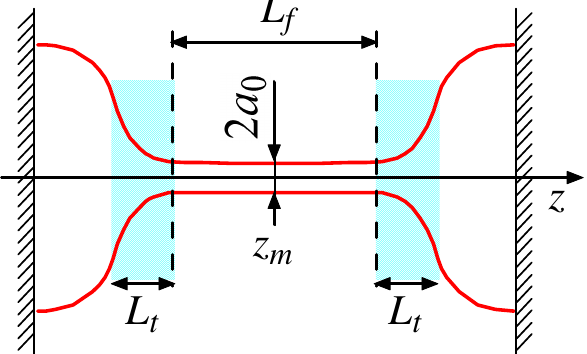
Figure 1. A thinning filament of radius a 0 and length L f connecting two semi-spherical droplets (a cross-section along the main axis is shown here); z m corresponds to the middle of the thread. L t (cid:28) L f is the size of the filament/droplet transition regions (shown in